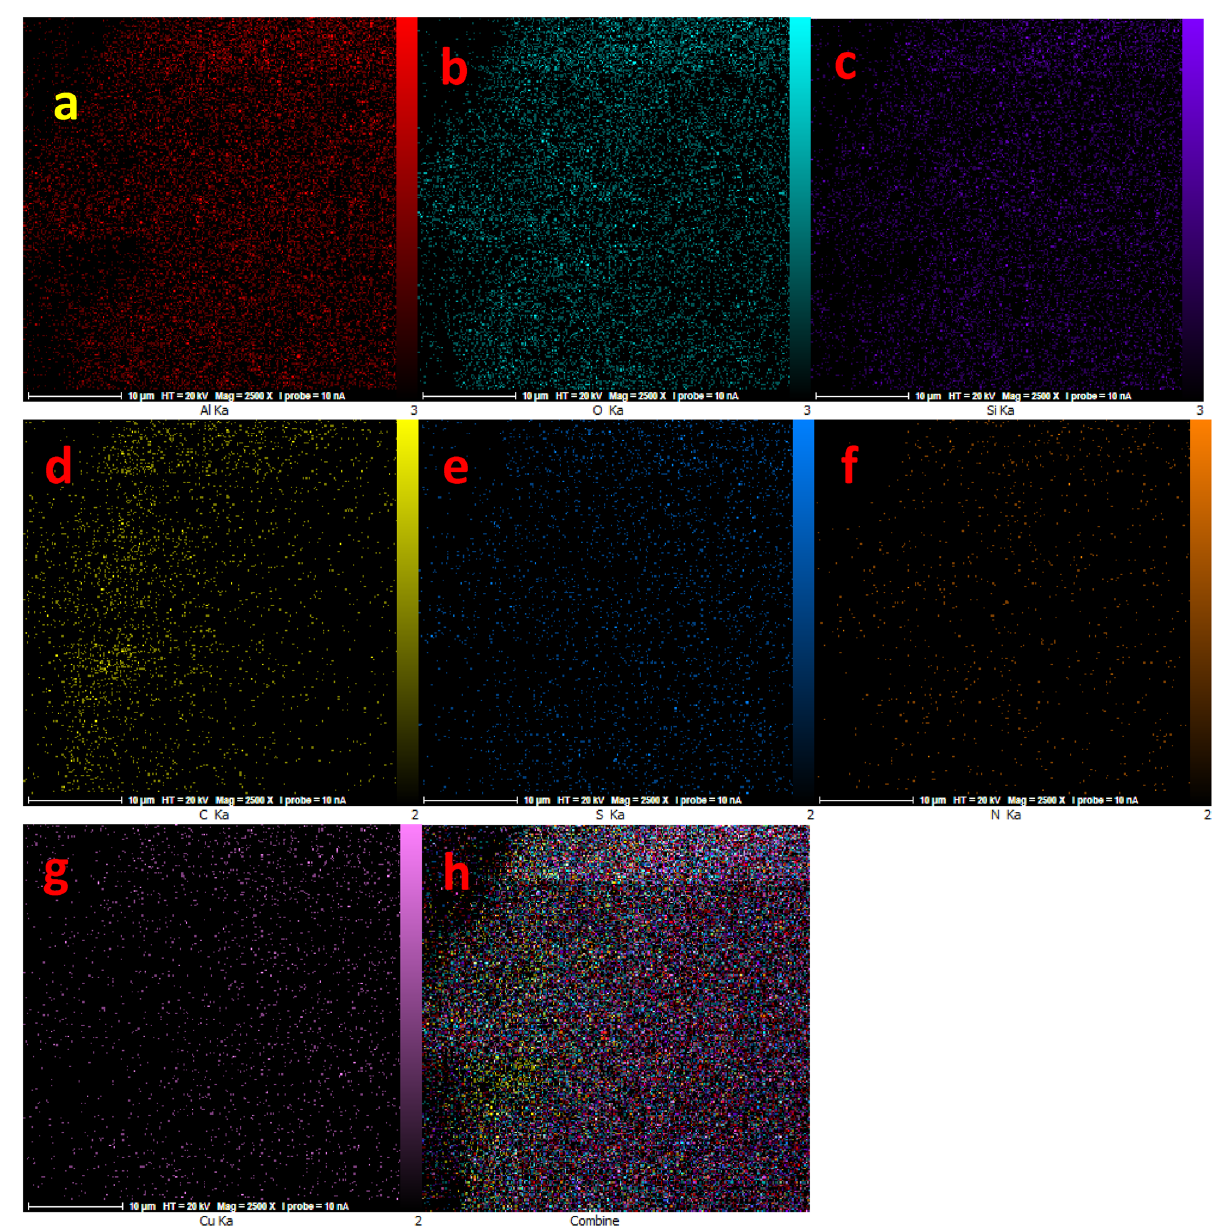
Figure 4. Elemental mapping of ( a ) aluminum, ( b ) oxygen, ( c ) silica, ( d ) carbon, ( e ) sulfur, ( f ) nitrogen, ( g ) copper and combine elements for